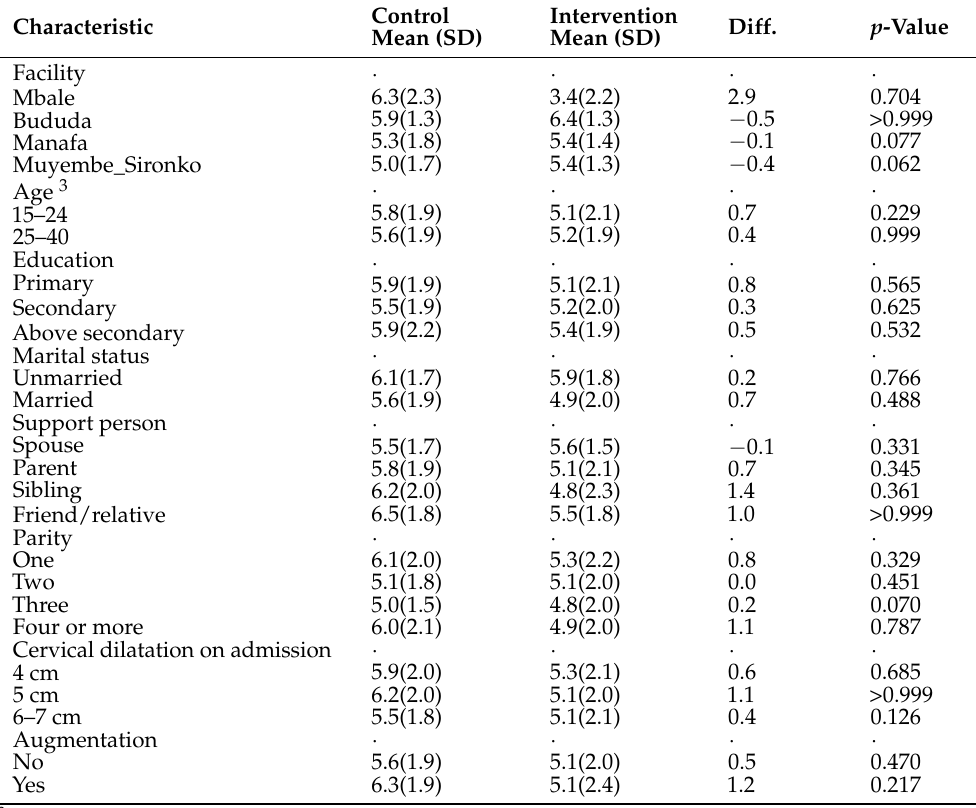
Table 2. Subgroup analysis; treatment effect on anxiety for specific baseline characteristics.